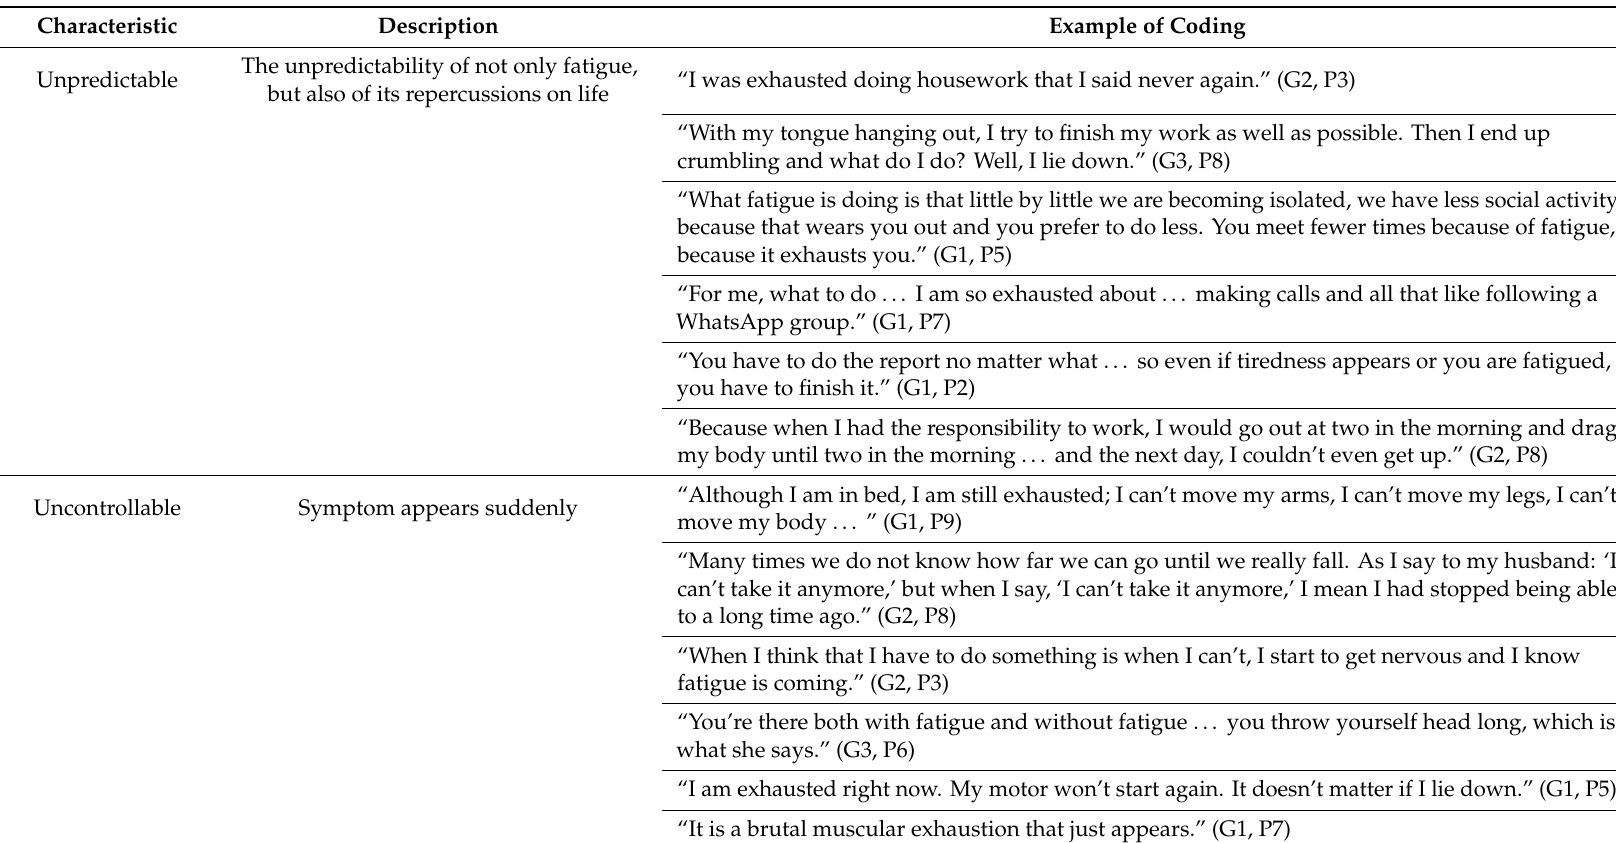
Table 6. Characteristics, descriptions, and examples for the coding of the 4U’s